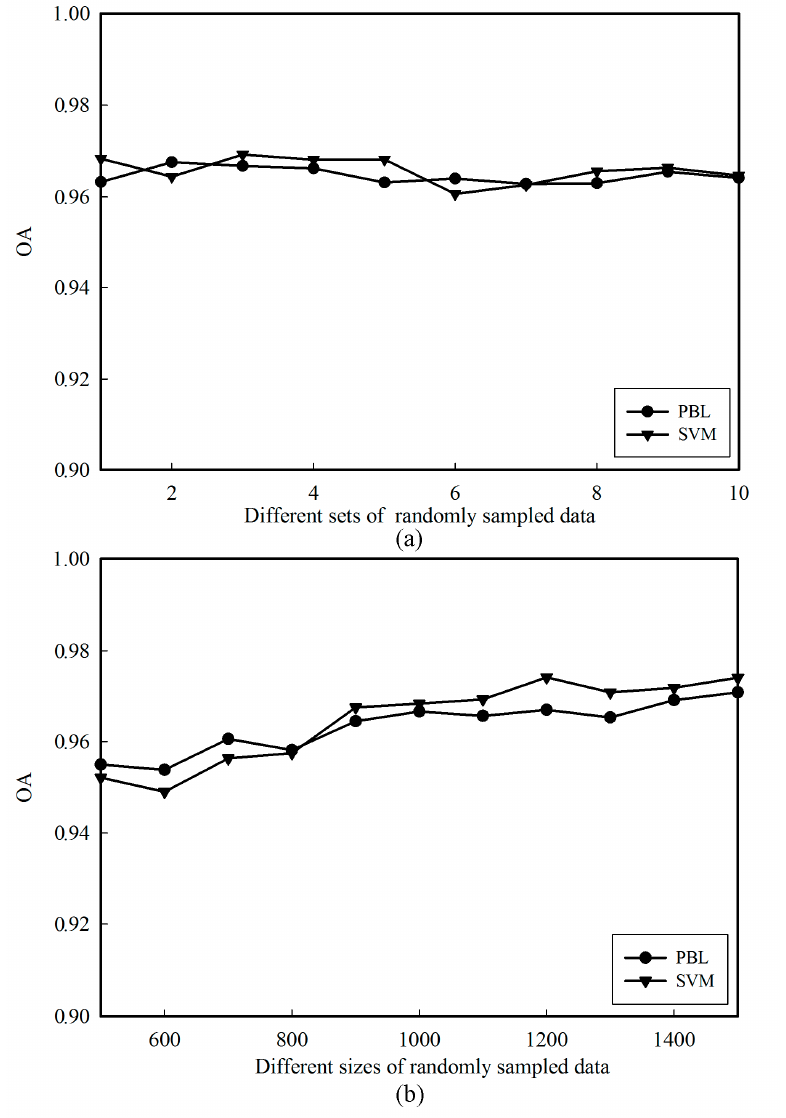
Figure 4. Comparison of overall accuracies (OAs) obtained from the presence and background learning algorithm implemented by back propagation neural network (PBL-BP) and support vector machine (SVM) using different randomly sampled training data: ( a ) different sets of randomly sampled data; ( b ) different sizes of randomly sampled data.